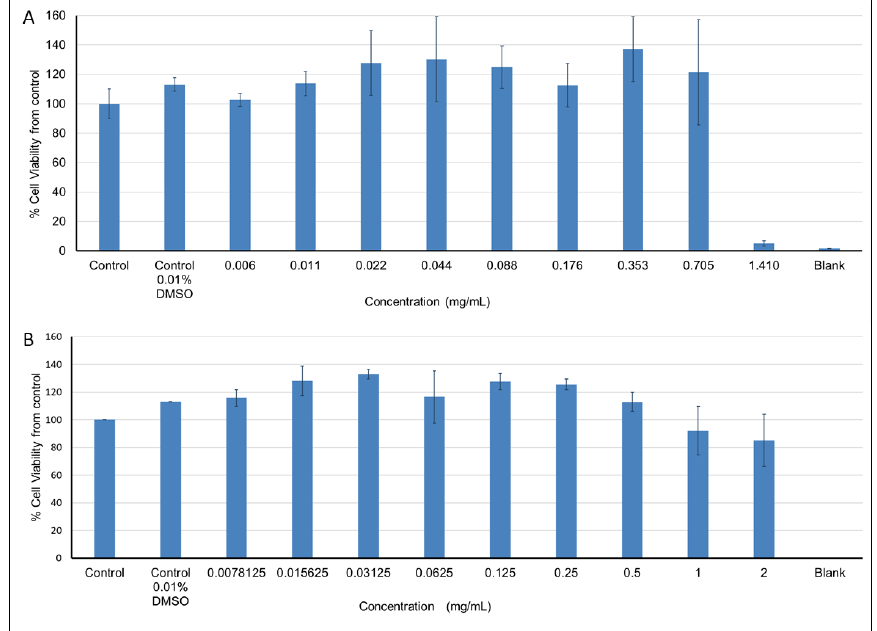
Figure 6. The effects of increasing concentrations of the plant extracts on the viability of L6- GLUT4myc cells: ( A ) Pelargonium spp. and ( B ) Rhus coriaria